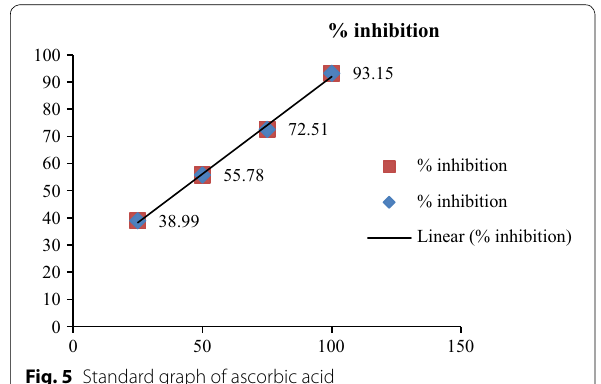
Fig. 5 Standard graph of ascorbic acid